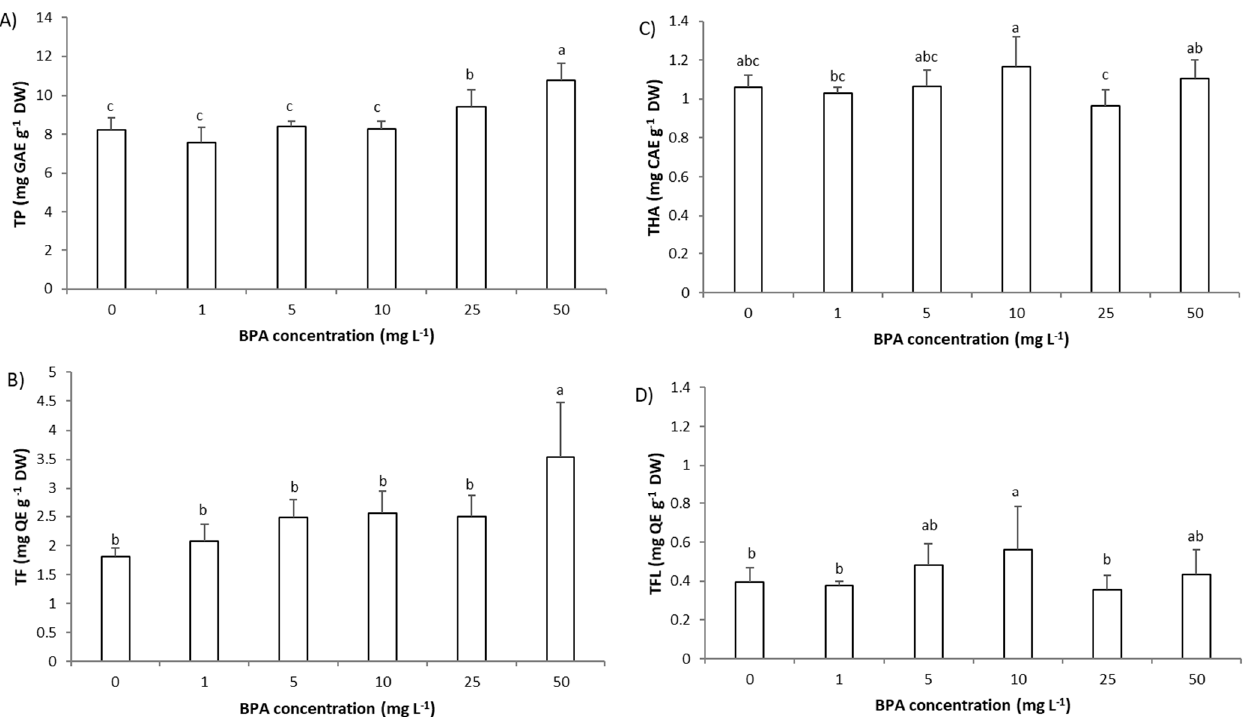
Figure 6. The level of phytochemicals in roots cells of Allium cepa exposed to bisphenol A (BPA) (1–50 mg L − 1 ) for 3 days. ( A ) level of total polyphenols (TP), ( B ) level of total flavonoids (TF), ( C ) level of hydroxycinnamic acids (THA), and ( D ) level of total flavonols (TFL) Results are presented as means ± SD (n = 5 replicates). Different letters indicate significant difference ( p ≤ 0.05). 0—control plants, not exposed to BPA.